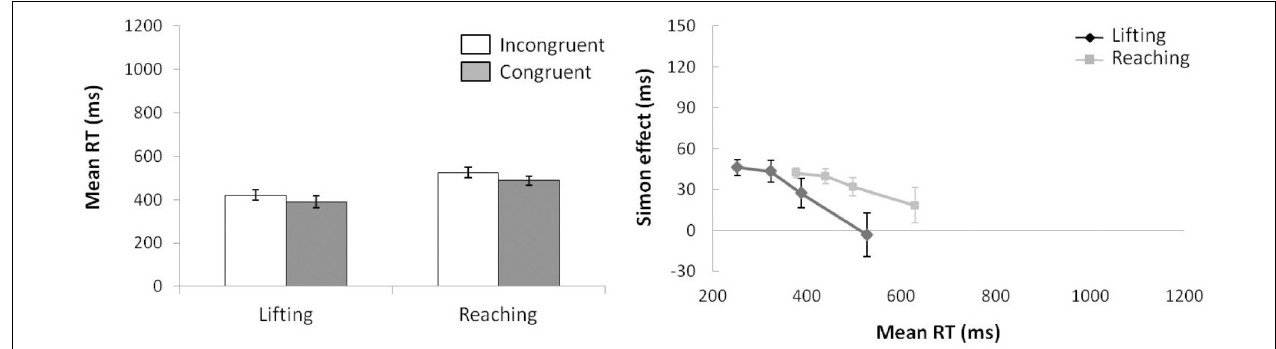
FIGURE 2 | (Left) Interactions of movement × congruence, with respect to mean reaction time. (Right) Delta-plots showing Simon effect magnitude as a function of response speed (expressed in reaction time quartiles) for lifting and reaching actions in Experiment 1. Error bars represent the standard error of the mean.